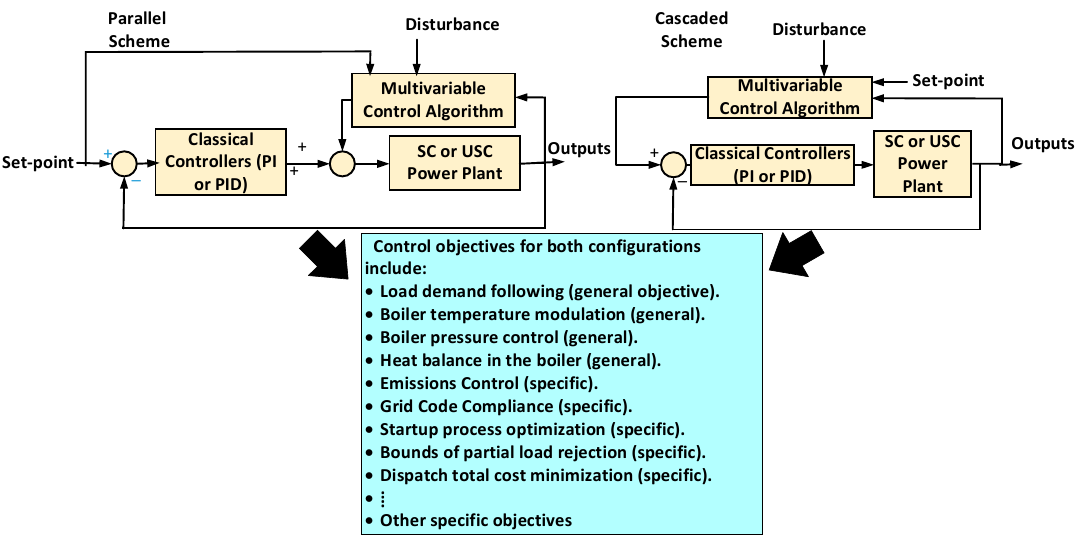
Figure 7. Modern control architectures and objectives.